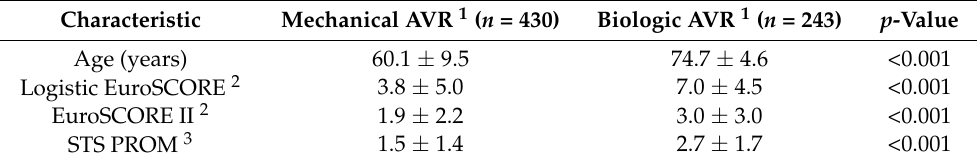
Table 5. Baseline characteristics.